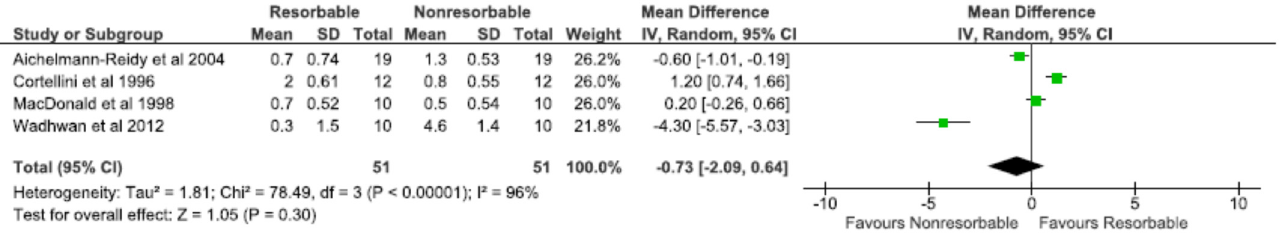
Figure 7. Subgroup analysis of clinical attachment level (CAL) at all intervals (6–12 months).